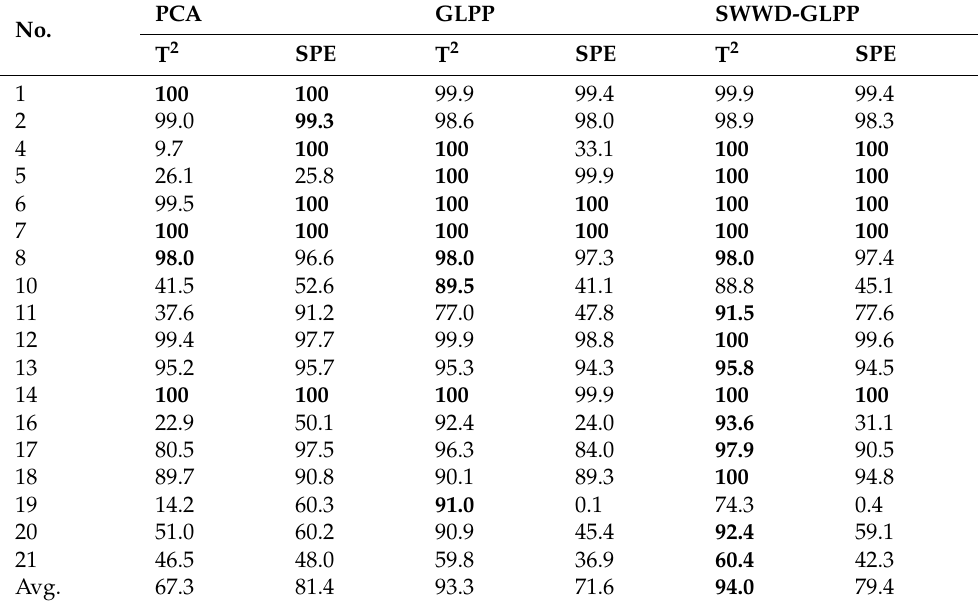
Table 1. Monitoring accuracy rate of the faults (%). PCA: principal component analysis and SWWD- GLPP: sliding window wavelet denoising-global local preserving projections. SPE: squared prediction error. Bold numbers: the best indicator results of all the methods.